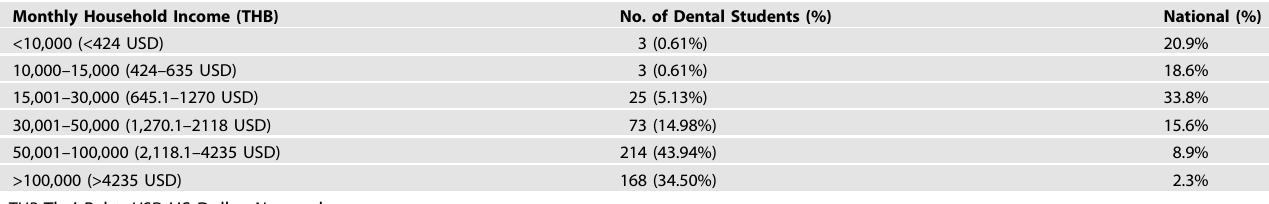
Table 5. Monthly household income of dental students and the national average. ( N =